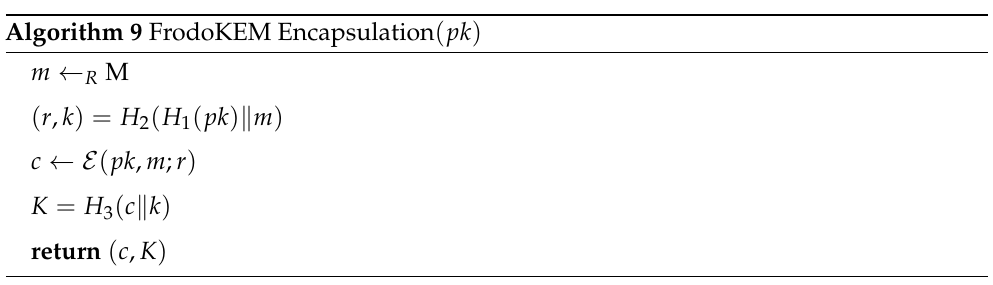
Algorithm 10 FrodoKEM Decapsulation ( sk , c